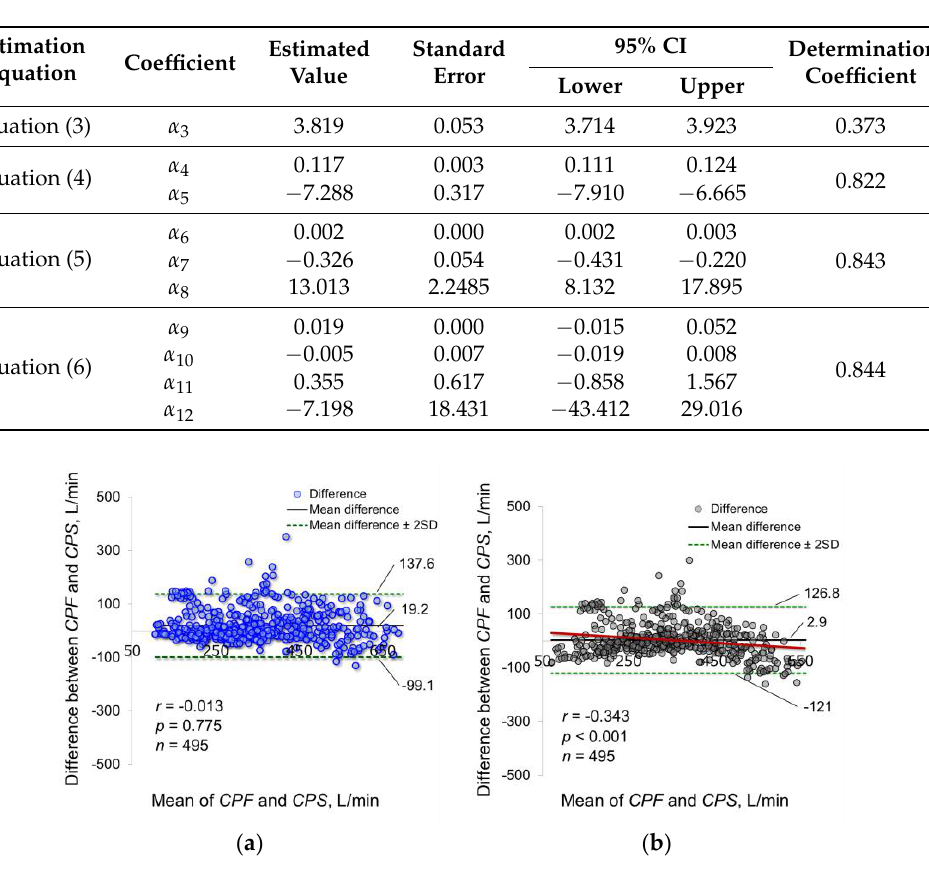
Figure 7. Bland-Altman plot of the measured and estimated cough peak flow. CPF , cough peak flow; CPS , estimated cough peak flow; ( a ) CPS estimated using our proposed model of Equation (1); ( b ) CPS estimated using Equation (4). Blue and black dots represent the difference between CPF and CPS . Bold black solid lines represent the mean difference between CPF and CPS . Green dotted lines represent the mean difference ± 2 standard deviation bands. Red lines represent the approximate straight line of the difference between CPF and CPS and the mean of CPF and CPS .